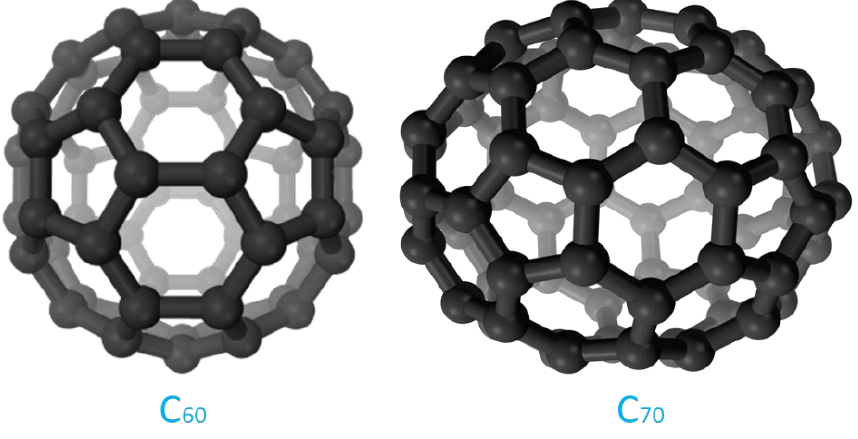
Figure 1. Comparison of C 60 and C 70 nanostructures.